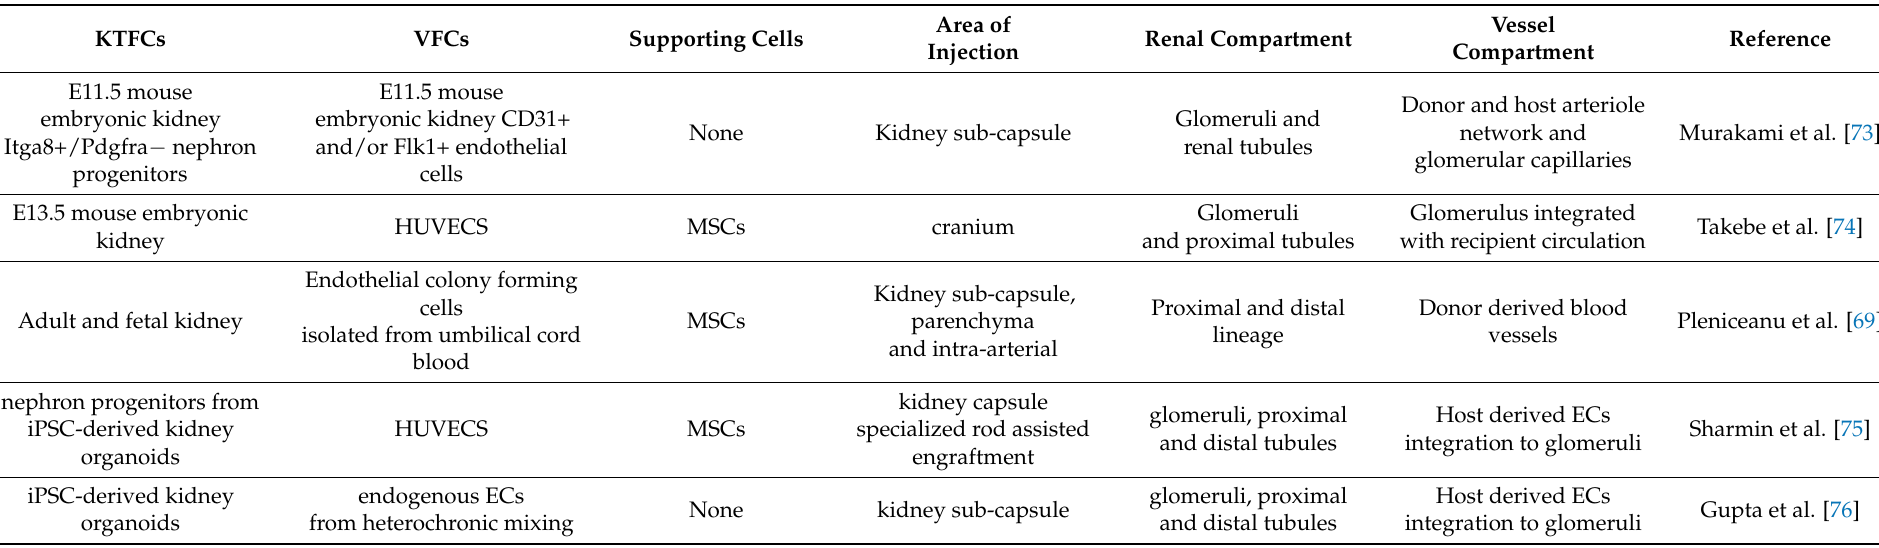
Table 2. Summary of studies mixing KTFCs with VFCs. KTFCs from fetal, adult kidneys and iPSC-derived kidney organoids. Primary VFCs used such as HUVECs, ECFCs, endogenous ECs from the developing fetal kidney and iPSC-derived organoids and